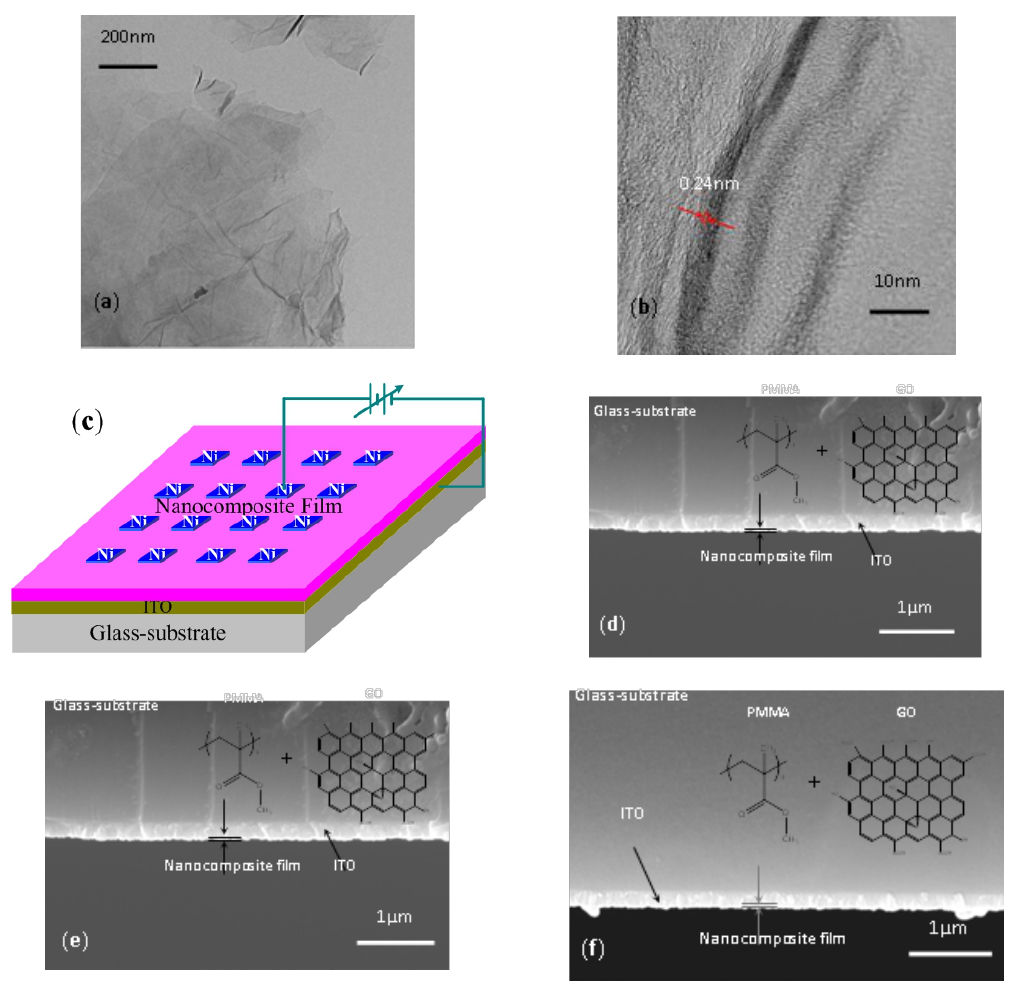
Figure 1. Characterization of GO and the PMMA:GO nanocomposite layer. ( a ) TEM and ( b ) High-resolution TEM micrographs of GO sheets; ( c ) Sandwiched configuration of Ni/PMMA:GO/ITO; ( d – f ) SEM images of cross-sectional characterization for PMMA:GO nanocomposite films with chemical component weight ratios of 2:1, 5:1, and 10:1. Among these images, PMMA structure and a schematic representation of GO are shown in the inset.